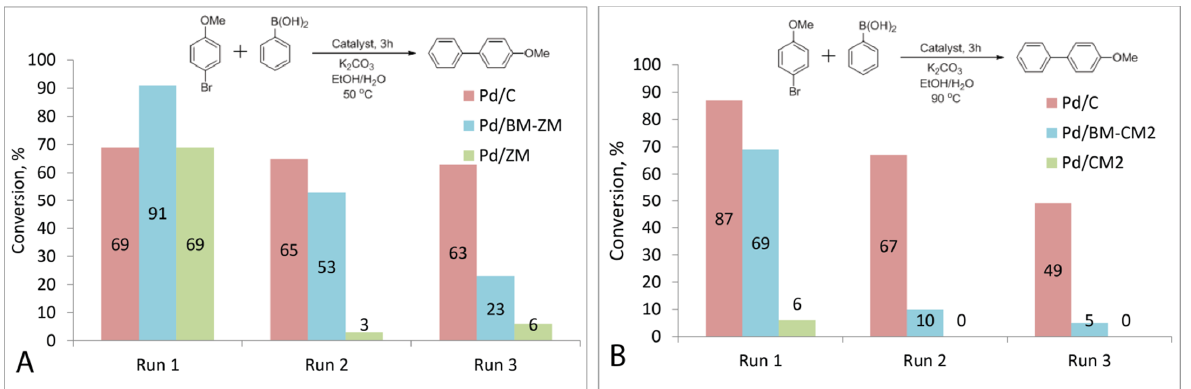
Figure 6. Recycling of supported palladium catalysts. Reaction schemes and histogram of recycling results for commercial Pd/C, Pd/ZM, Pd/BM-ZM ( A ) and Pd/CM2, Pd/BM-CM2 ( B ).